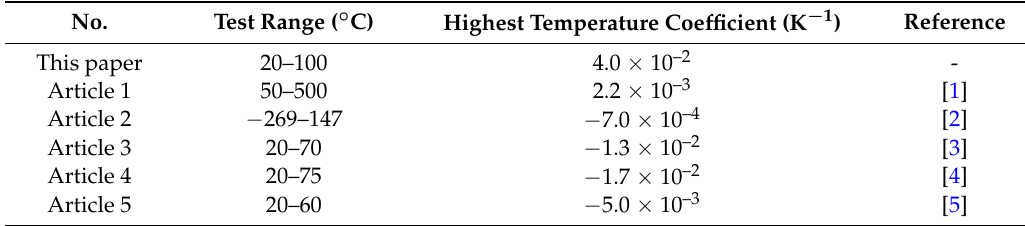
Table 1. Performance comparison of the temperature sensors.